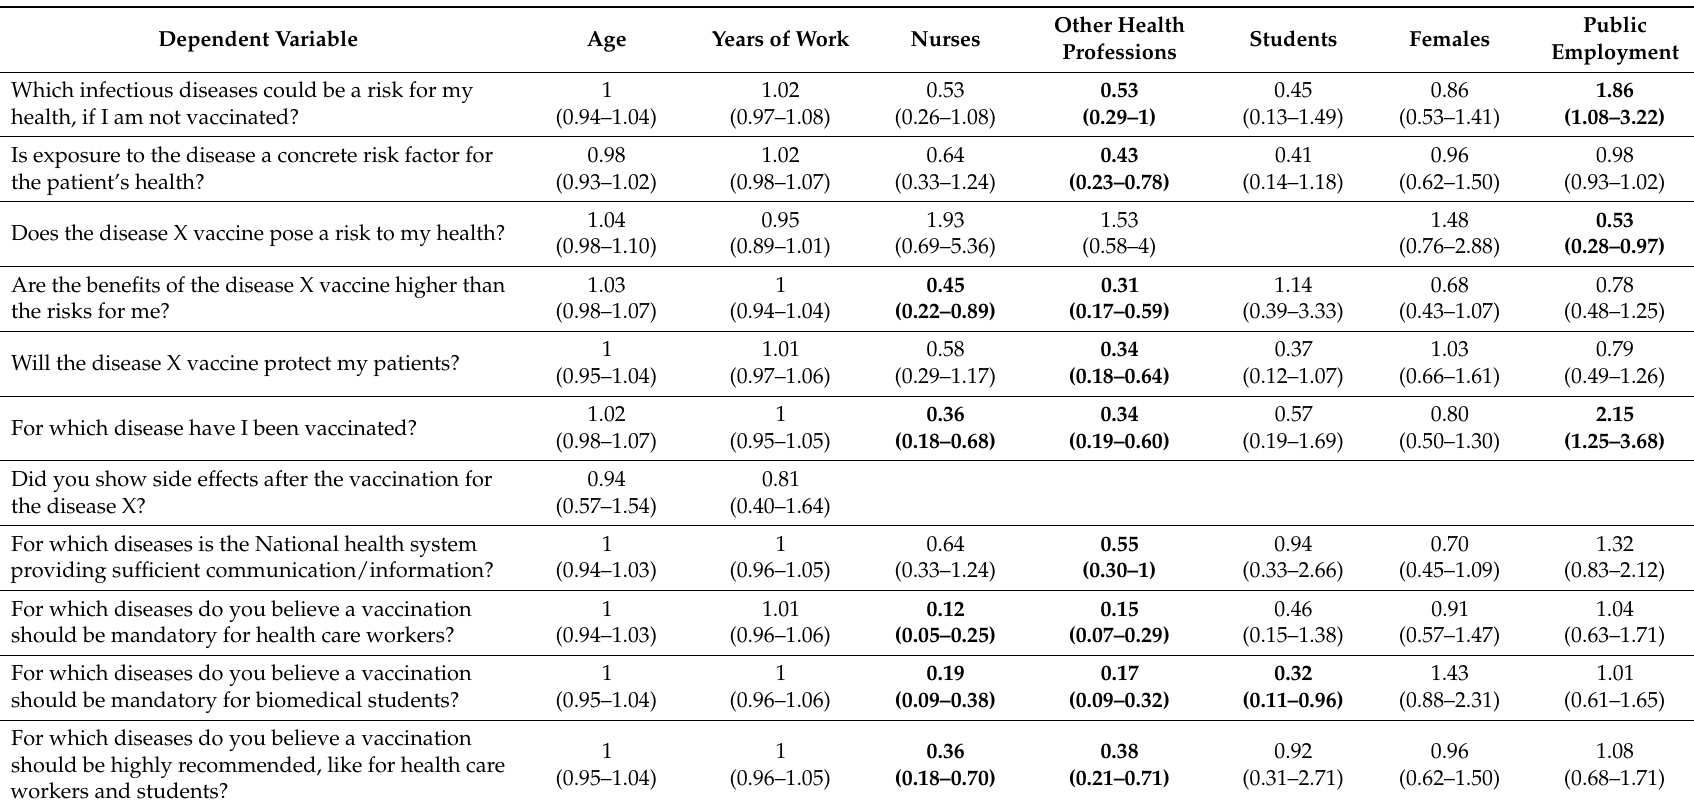
Table 5. Results of the multivariate analysis considering